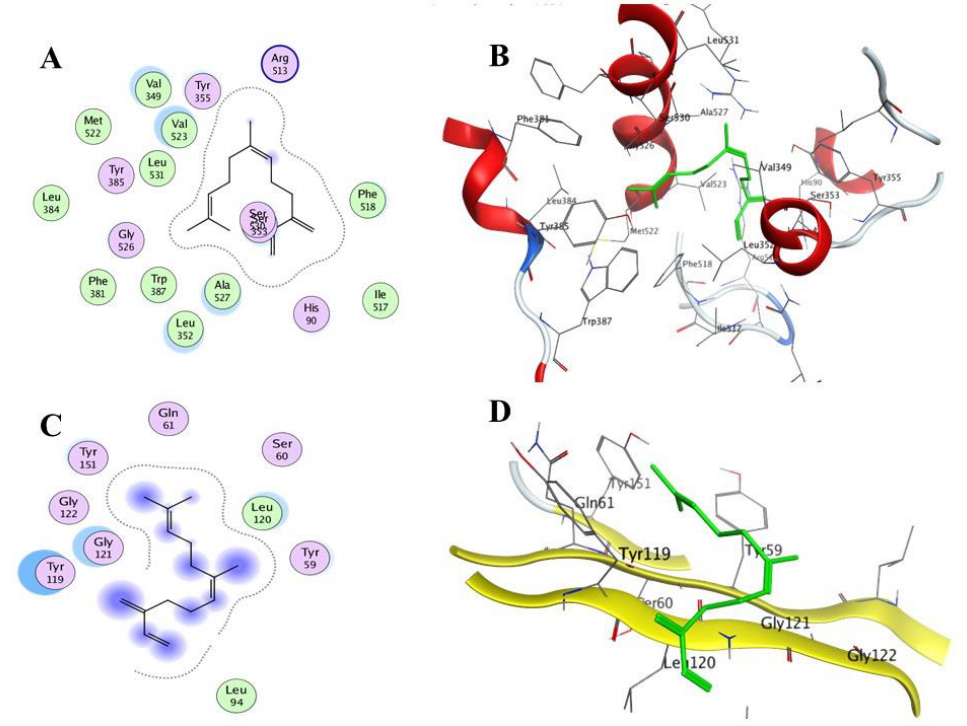
Figure 7. 2D and 3D interactions complex of compound 16 ( cis - β -Farnesene) with the COX-2 ( A , B ) and TNF- α ( C , D ) receptors ’ active